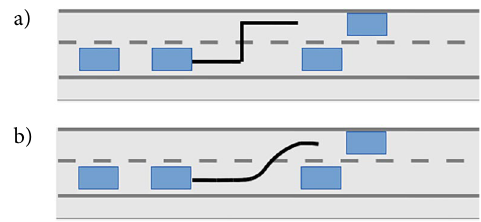
Figure 6. Continuous (a) and discrete (b) lane change